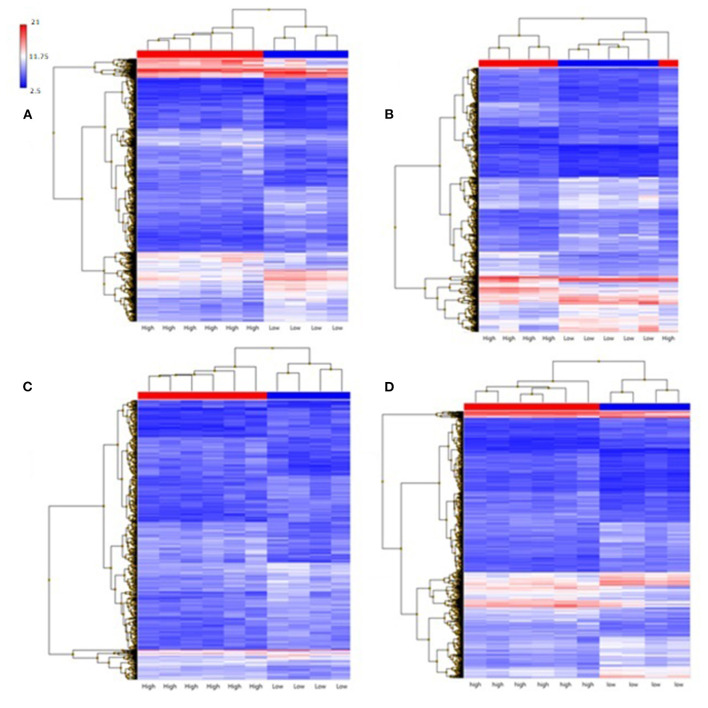
Hierarchical clustering of gene expression of aneurysmal tissues, samples classified as high are red and samples classified as low are blue. (A) ILT; (B) TAWSS; (C) Strain; (D) RAW. 10 aortic samples were analyzed, with one microarray being performed on each tissue sample.